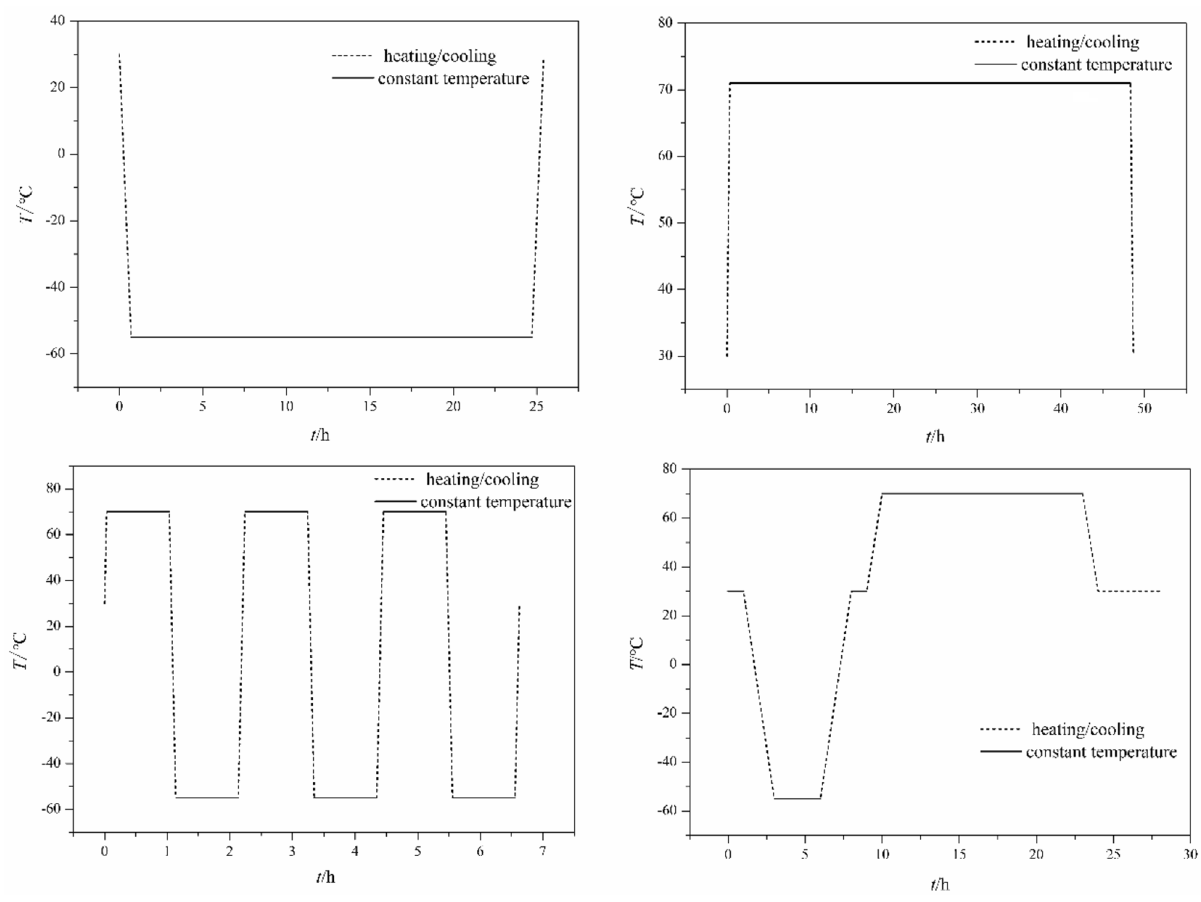
Figure 2. Temperature variation settings of different temperature adaptability